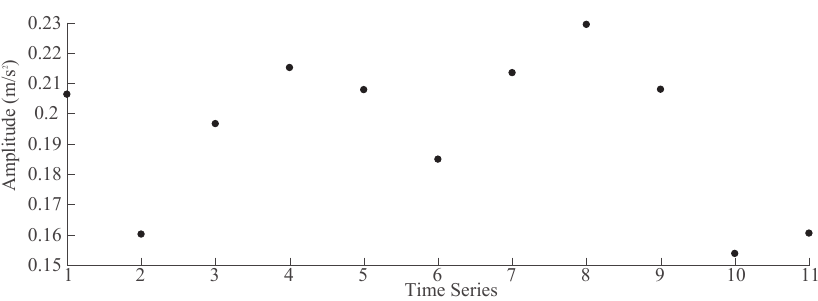
Figure 10. RMS values estimated by using the main bearing vibration signals.